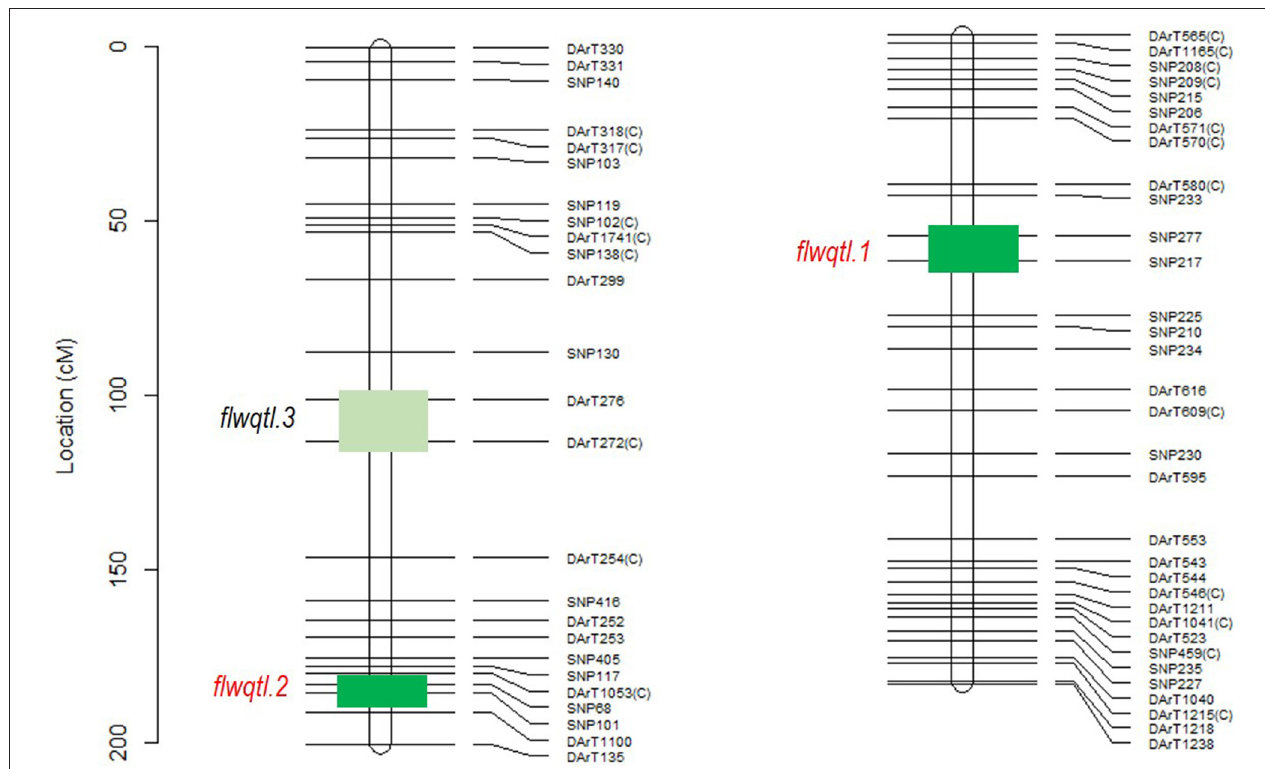
FIGURE 3 | QTL analysis of flowering loci segregating in Rupali/Genesis836 population across three different environments; glasshouse, Merredin2017, and Merredin2018 under non-saline conditions. Green boxes show approximate genomic regions where the flowering loci map. Flowering QTL, flwqtl.3 on CaLG03 was only identified in Merredin2018 while flwqtl.1 and flwqtl.2 on CaLG05 and CaLG03, respectively , we re identified in the glasshouse, Merredin2017 and Merredin2018 by both single environment QTL analysis and multi-environment QTL analysis. %GVE-percent genotypic variation